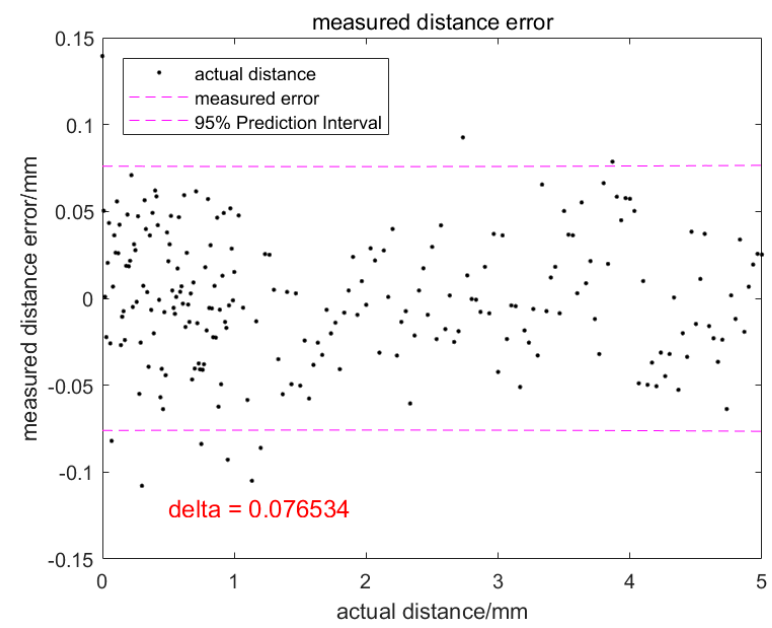
Figure 10. Droplet transfer distance detection error.